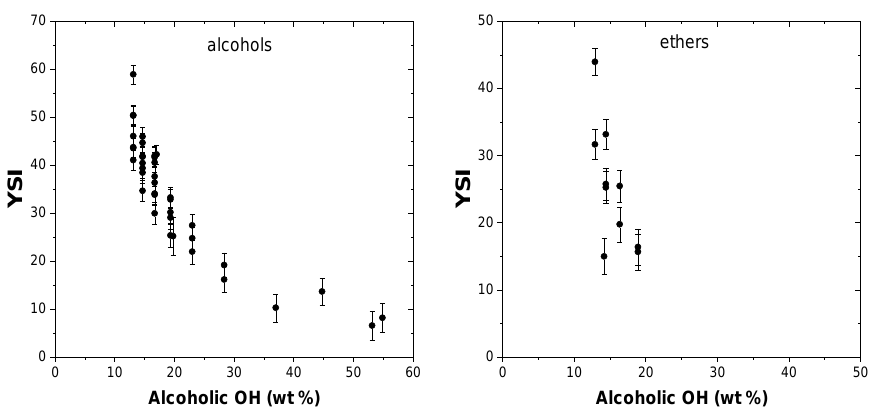
Figure 9. Effect of alcoholic OH groups on YSI .